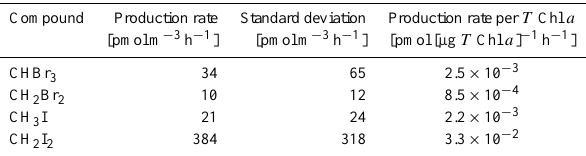
Table 7. Theoretical mean production rate of the four halocarbons in the equatorial mixed layer with the standard